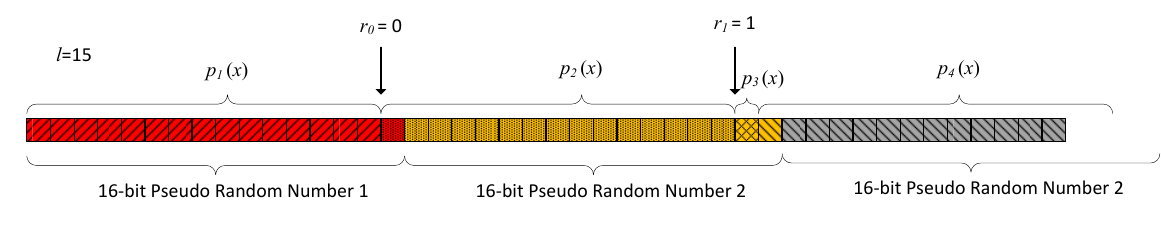
Figure 1. Generation of two random numbers in J3Gen. Table 1. Application of Primitive Feedback Polynomials in